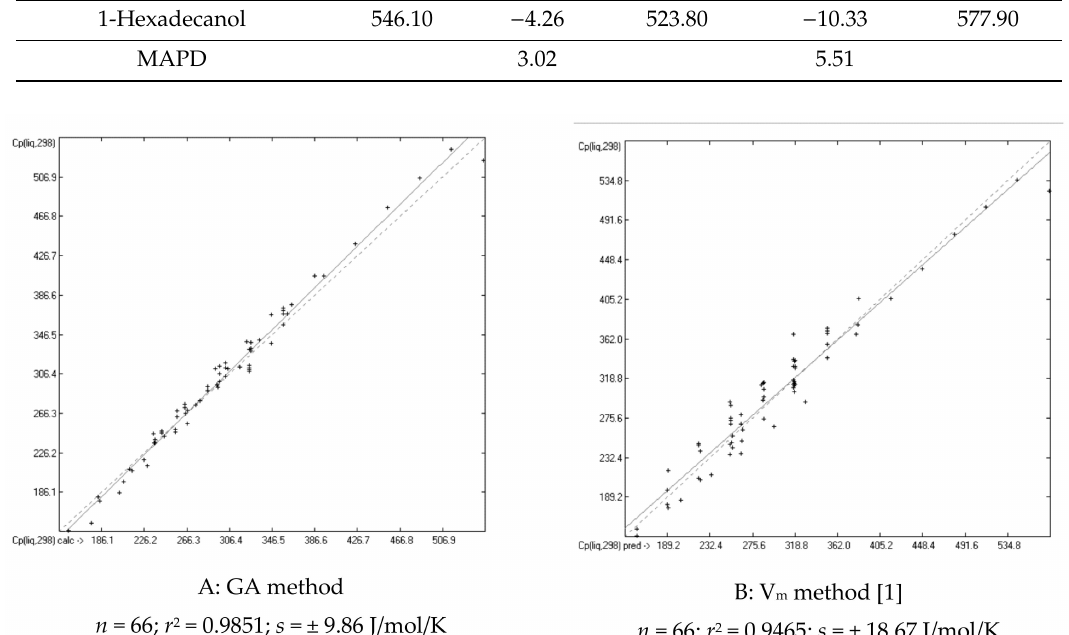
Figure 3. Correlation diagrams of the calculated vs. experimental C p (liq,298) data of saturated